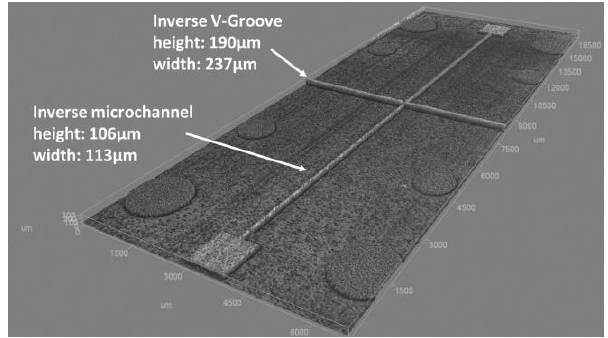
Figure 6. Machined “ inverse ” microchannel and V-grooves main dimensions measured with confocal microscope Zeiss Axio CSM 700 (magnification 10X with Numerical Aperture 0.25, lateral digital resolution of 160 nm and vertical resolution of 0.5 µm).